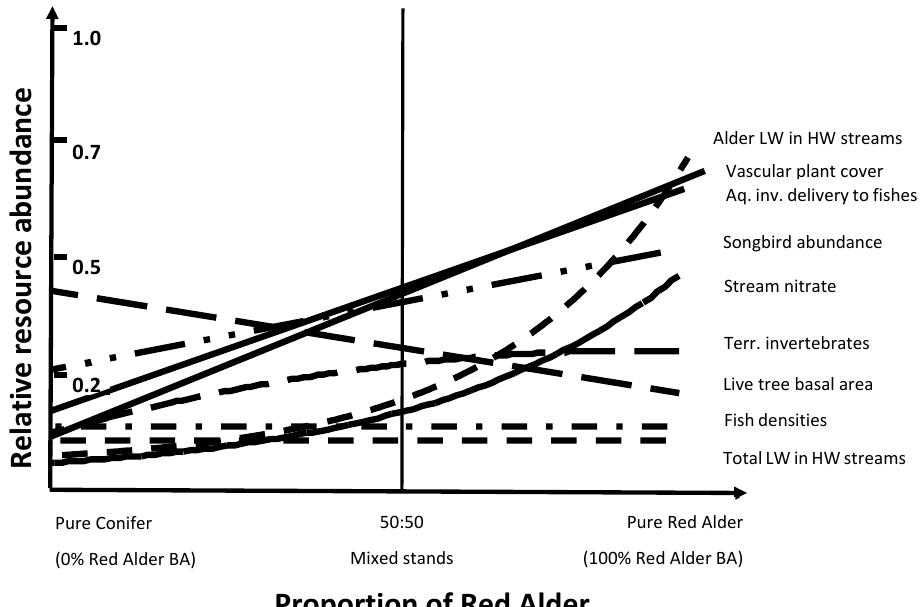
Figure 5. Conceptual model of ecosystem services tradeoffs in young-growth stands with proportion of alder in mixed red alder-conifer stands in southeast Alaska. Legend abbreviations: LV, large wood; HW, headwater; Aq. Inv., aquatic invertebrates; Terr., terrestrial. Responses start from the y -axis at approximate position in unharvested systems and progress along the x-axis as a proportion of red alder gradient.